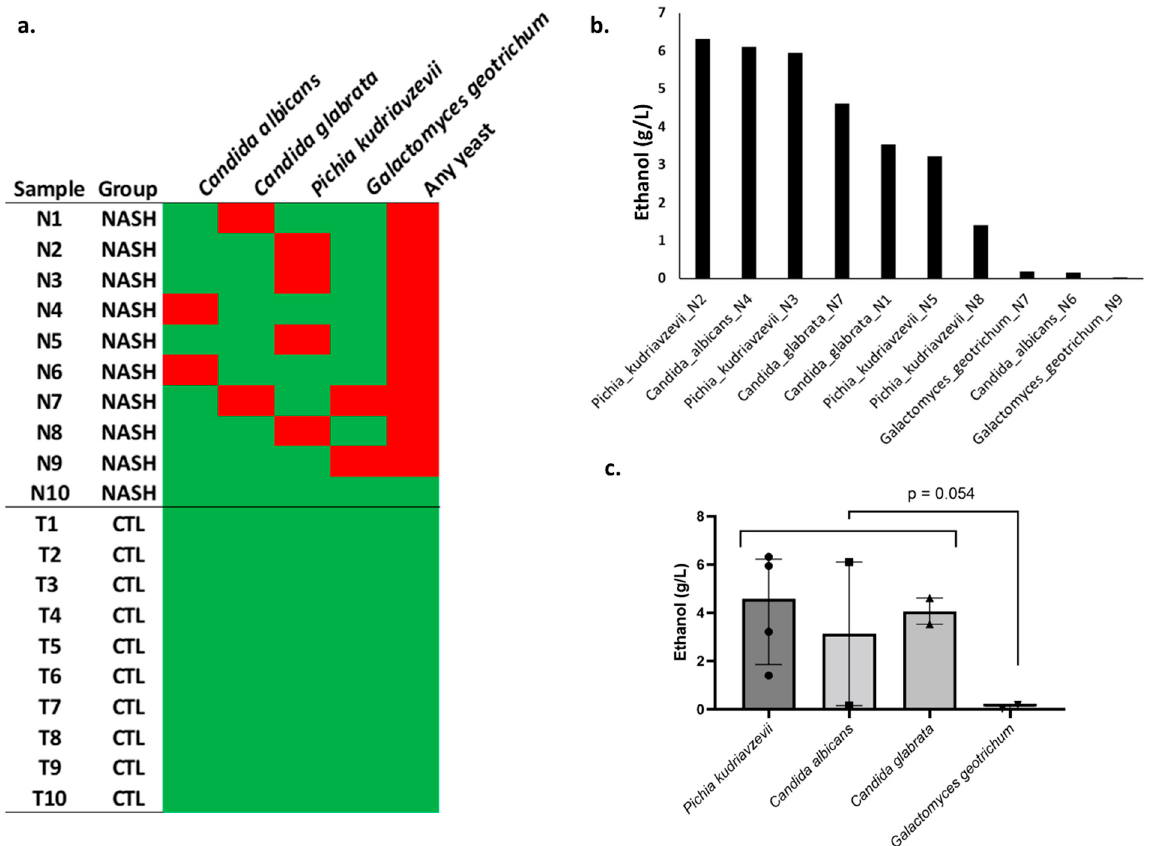
Figure 2. Isolation and ethanol production by yeast strains in an in vitro experimental model. ( a ) Yeast species isolated from each sample (N1, Patient Nash1, etc.). NASH: nonalcoholic steatohepa- titis, CTL: healthy controls. Red square: isolation of yeast in culture. Green: no yeast isolated. ( b ) Ethanol production for each strain in an in vitro experimental model (Sabouraud medium, high- performance liquid chromatography); each strain was named with the species and the patient (for instance, Pichia_kudriavzevii_N2 is a strain isolated from patient Nash2). ( c ) Comparison between species.